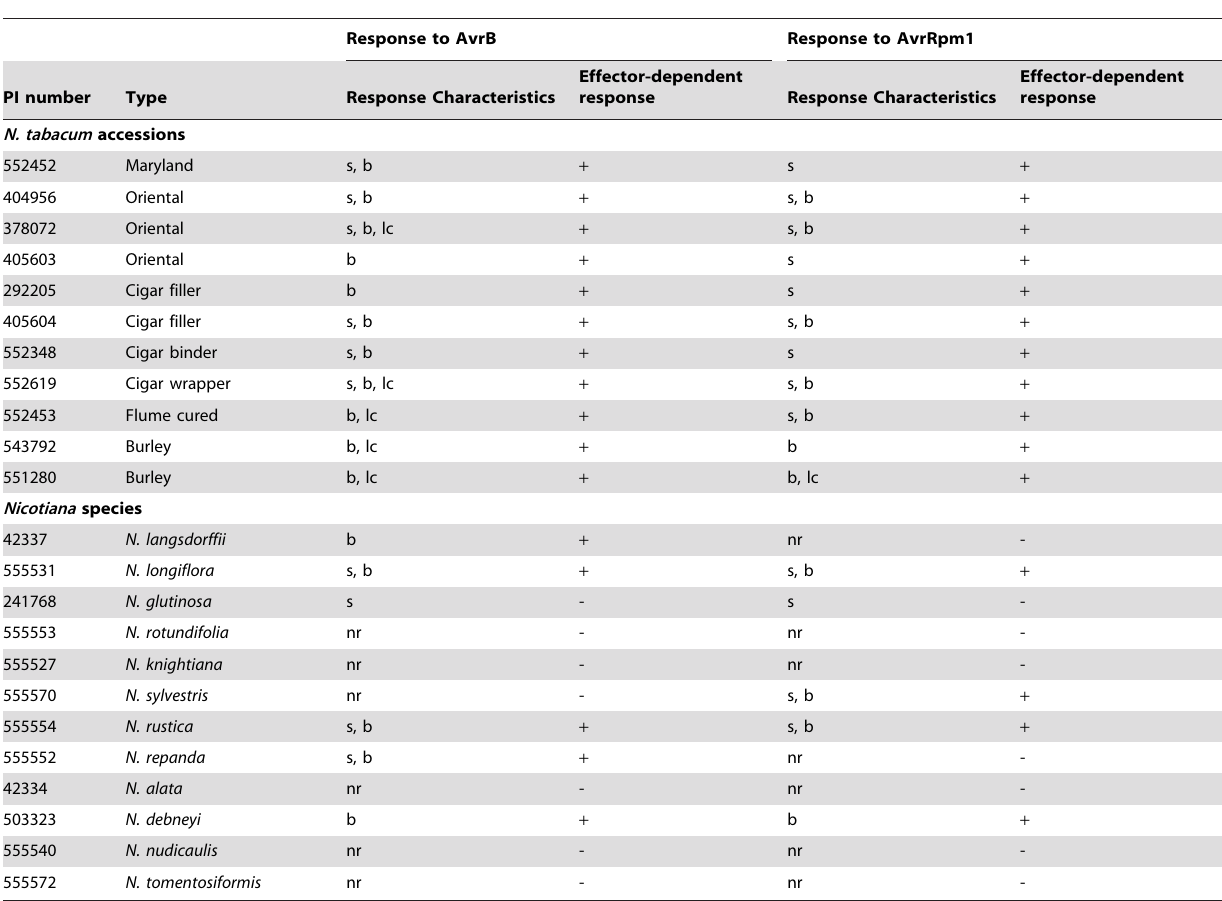
Table 1. Nicotiana accessions used in this study and their responses to AvrB and AvrRpm1.